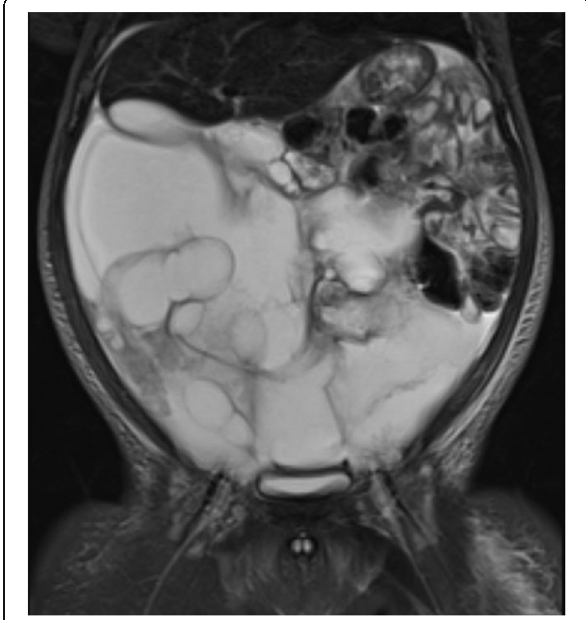
Fig. 10 Coronal T2 weighted MR image of a large mesenteric lymphatic malformation in a 2 year old male. This lesion would be suitable for serial sclerotherapy via 2 – 3 pigtail